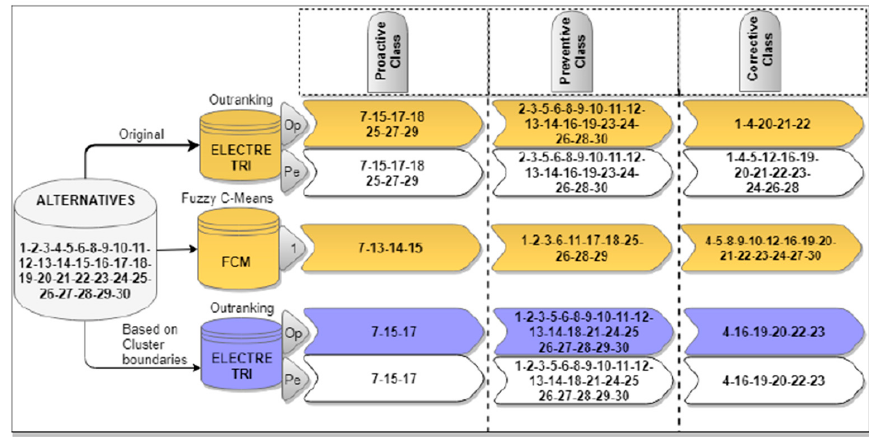
Figure 5. Results after clustering boundaries definition.